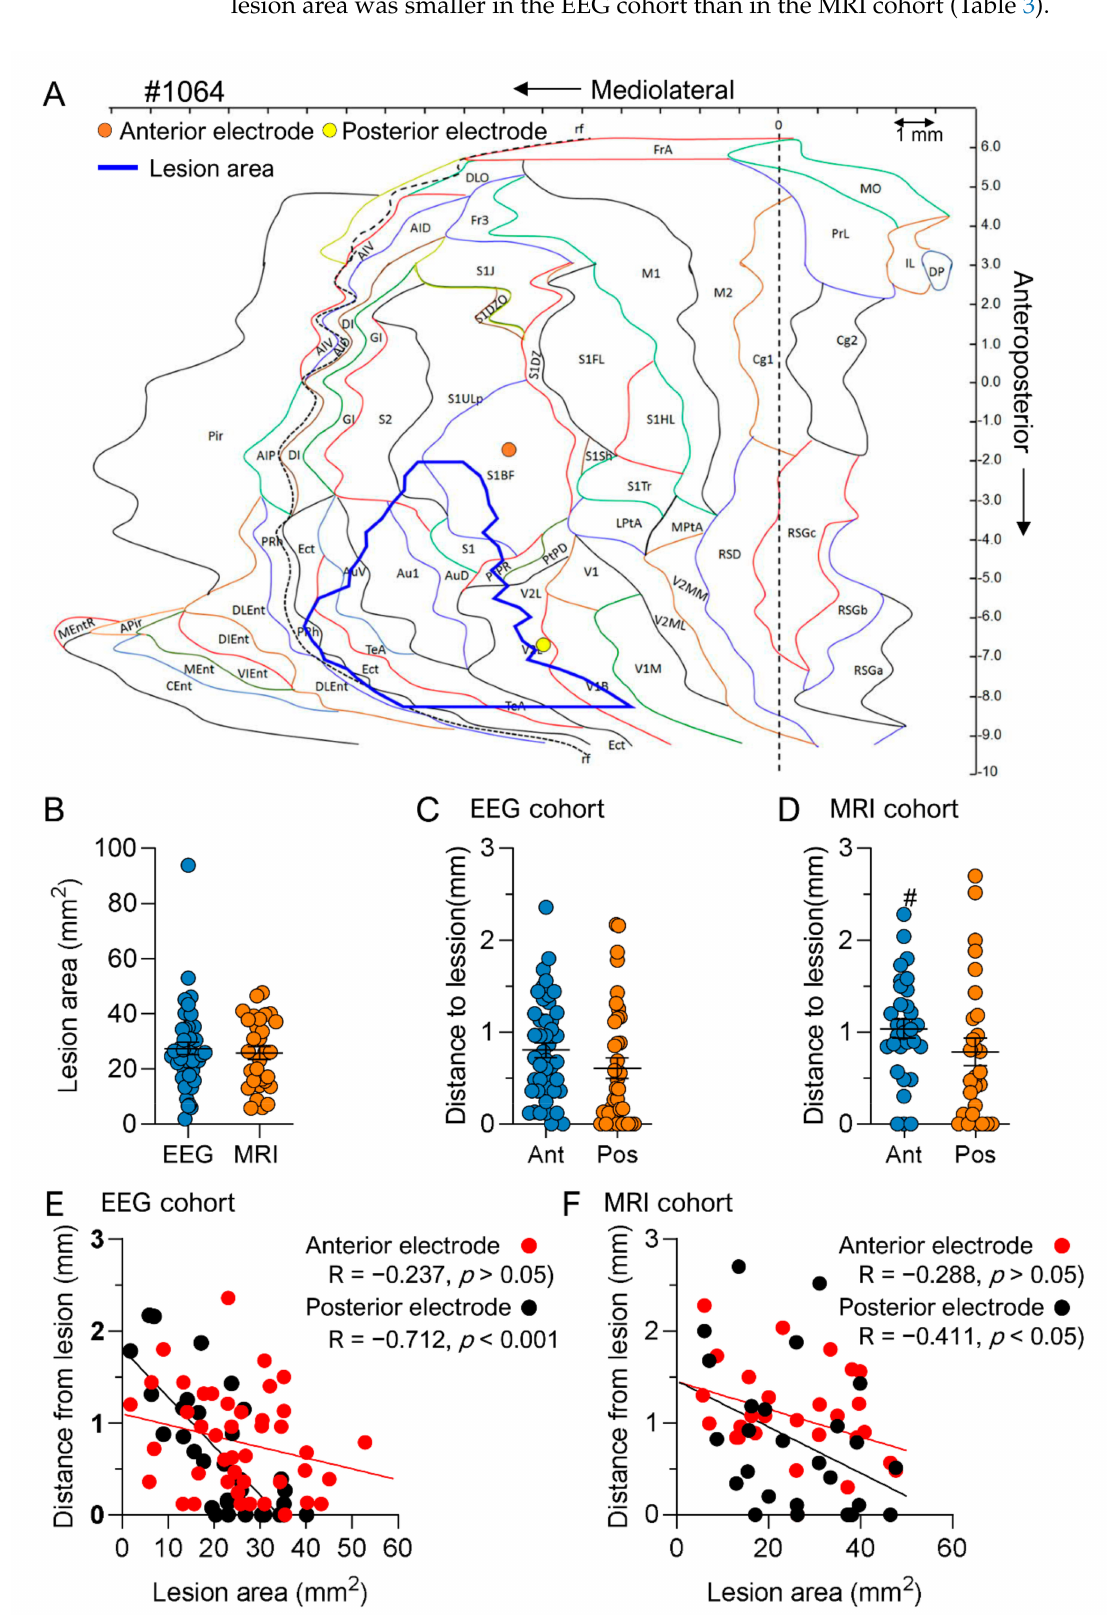
Figure 11. Distance of the intracortical electrodes from the edge of the cortical lesion cavity. ( A )